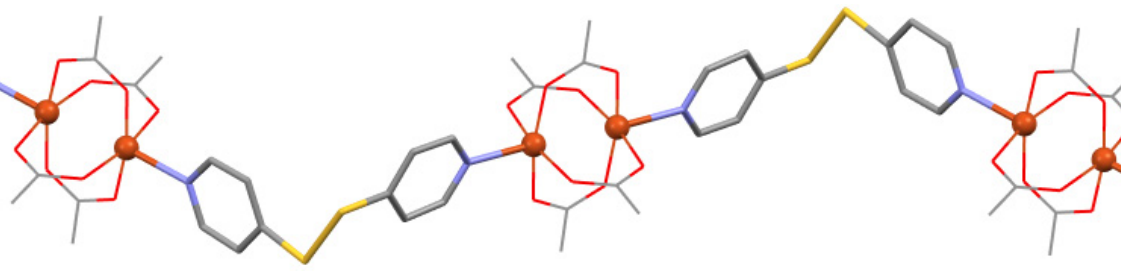
Figure 22. Achiral zigzag chain structure in [Cu